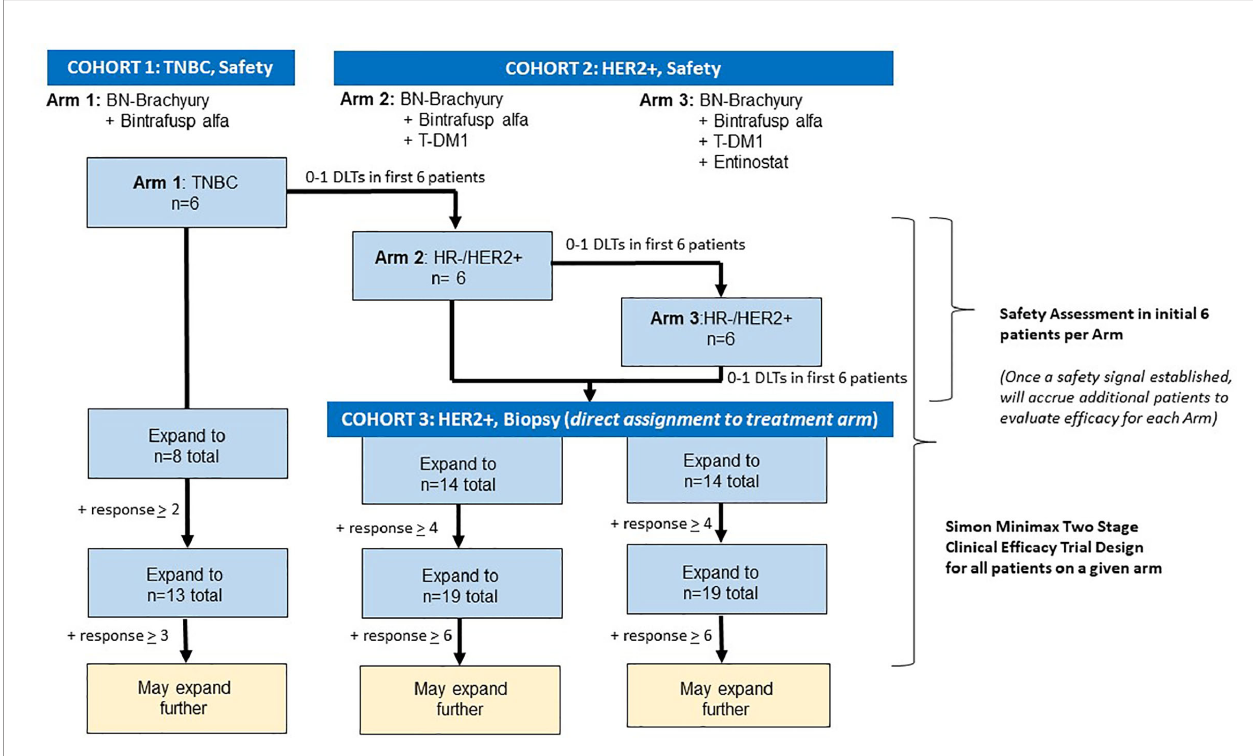
FIGURE 3 | Trial schema. The BrEAsT study contains three separate, single arm phase 1b trials that evaluate the safety and ef fi cacy of the sequential addition of immunotherapy agents with the goal of rapidly escalating to the 4-drug combination to lead to the best anti-tumor control and immune in fi ltration seen in the preclinical studies. Each arm starts with a safety assessment of the drug combinations with DLT assessments in the fi rst six patients on each arm. Following the demonstration of safety, additional patients will be enrolled using a Simon 2-stage clinical ef fi cacy design. DLT, dose limiting